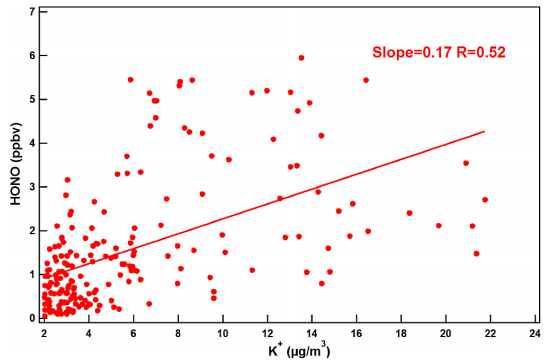
Figure 5. Scatter plot between the HONO and potassium concen- tration during BB periods. Figure 6. Ratios of HONO to NO 2 for nighttime samples of BB